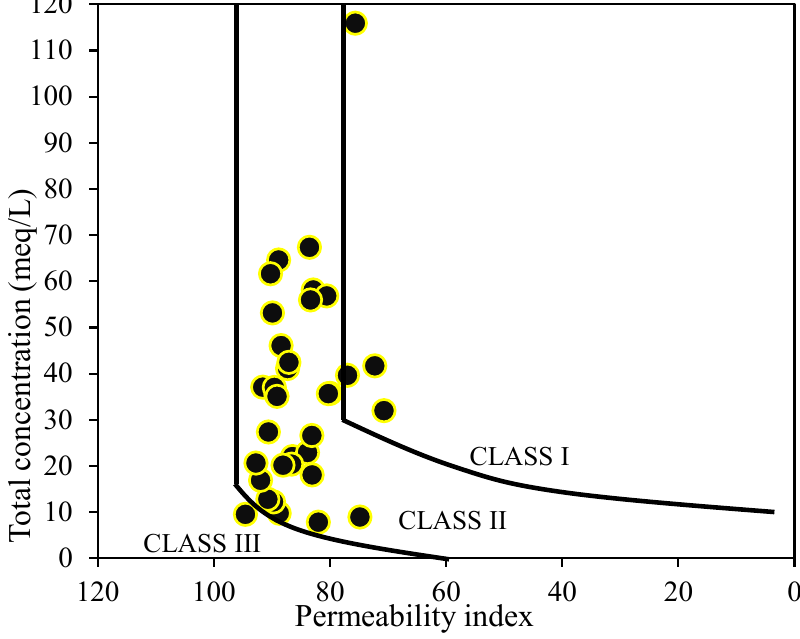
Figure 10. Permeability index vs. total ions.